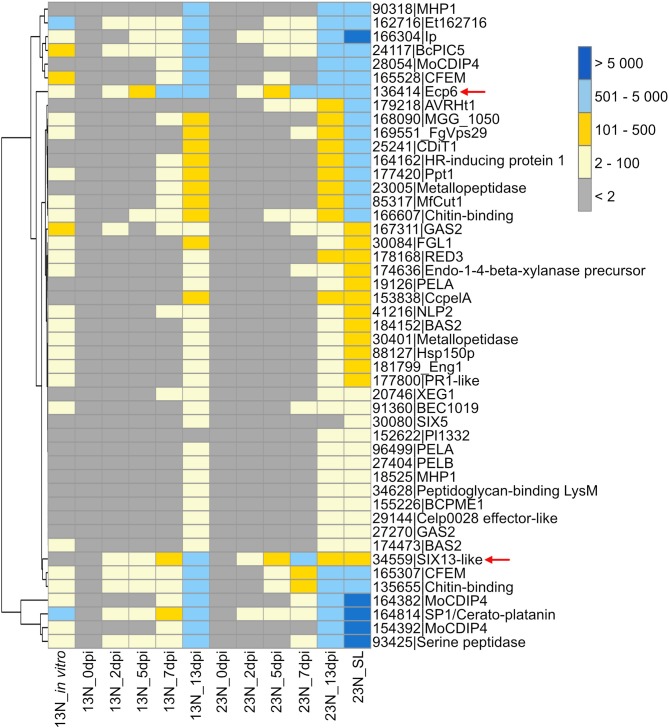
Transcriptional profiles of Exserohilum turcicum candidate secreted effector proteins similar to known effector proteins which affect virulence. A subset of candidate effectors was selected based on similarity to known proteins on the PHI-Base or NCBI database, annotations, or literature. The scale bar indicates the read count values. Row names are given as protein identifier|Gene name/description. Column names indicate the isolate race (13N or 23N) as well as days post-inoculation (dpi). Arrows indicate candidates selected for reverse transcriptase quantitative PCR (RT-qPCR) analysis.